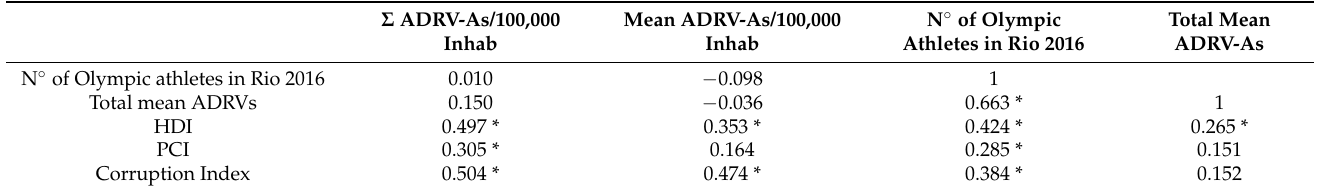
Table 2. Relationship between ADRV-As prevalence variables and socioeconomic indexes between 2013 and 2018.